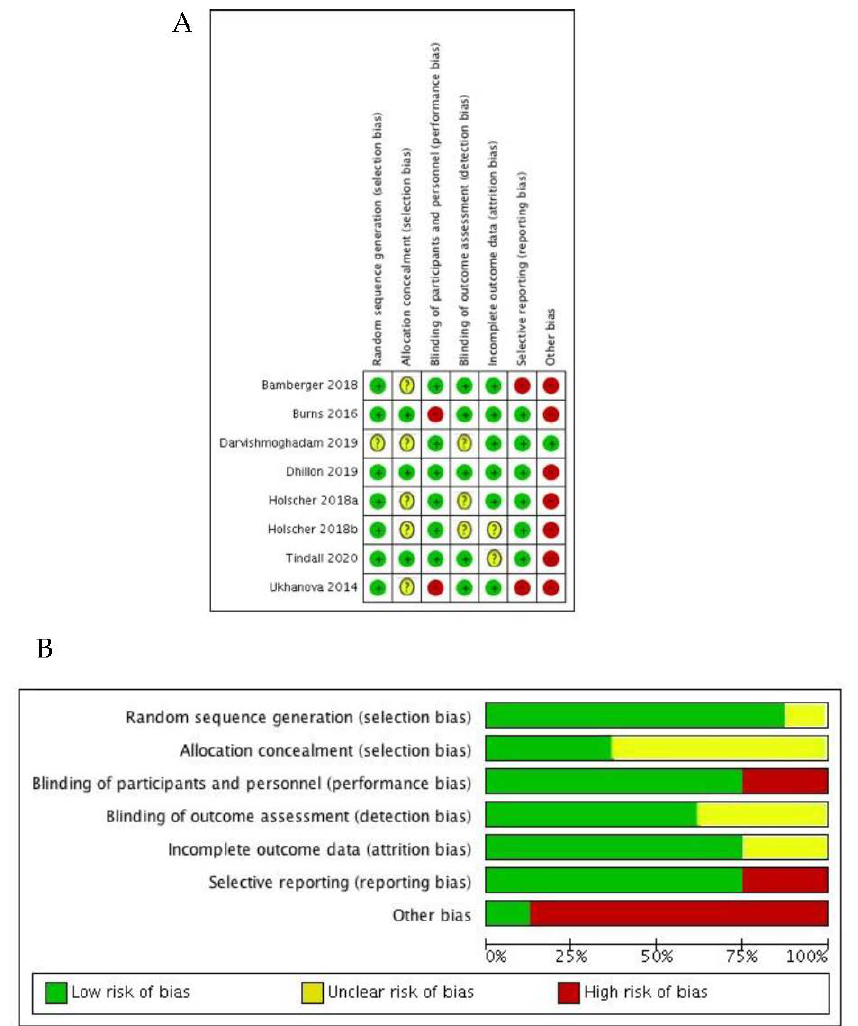
Figure 6. Risk of bias in studies investigating the impact of nut consumption on gut microbiota and gut function. ( A ) Risk of bias in individual studies. ( B ) Risk of bias across studies for each category.